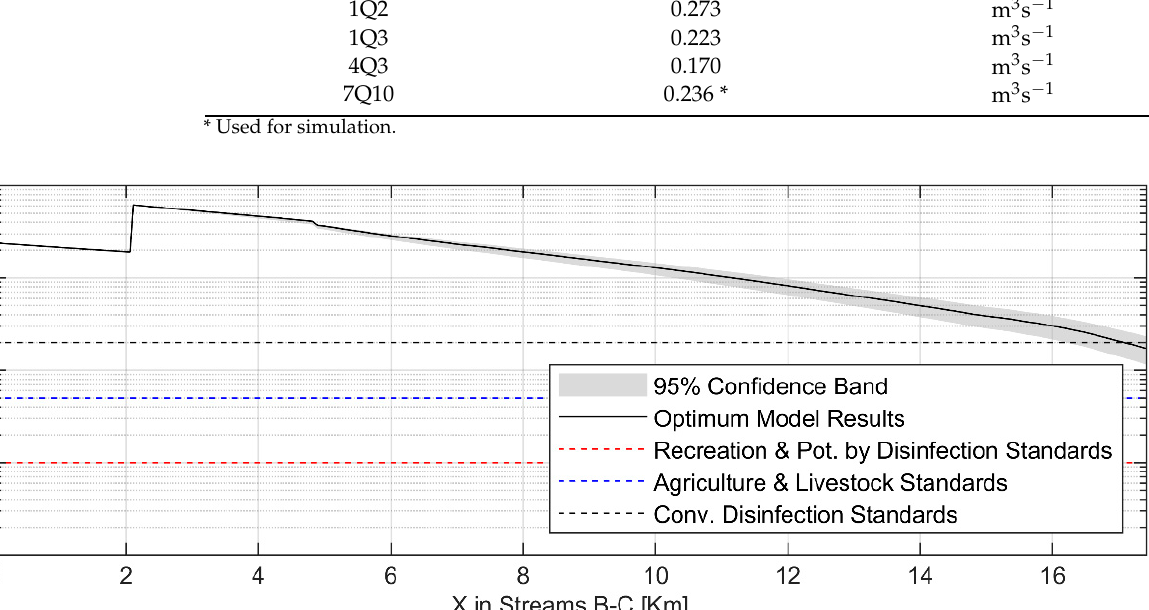
Figure 10. Critical scenario results for total coliforms in Streams B and C.